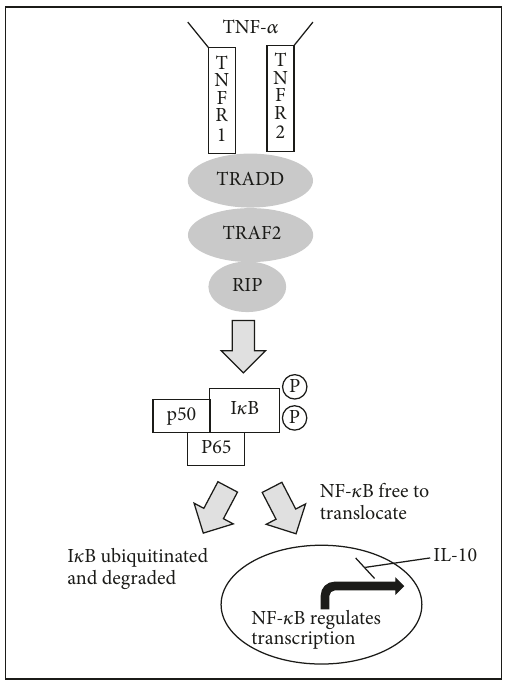
Figure 2: TNF- 𝛼 activation of NF- 𝜅 B pathway. Upon binding with the receptor, TNF- 𝛼 permits activation of IKK complexes, which then phosphorylate I 𝜅 B. Phosphorylated I 𝜅 B is then targeted for degradation, allowing NF- 𝜅 B to translocate to the nucleus to regulate tumorigenic activity and immune defense. IL-10 inhibits this response